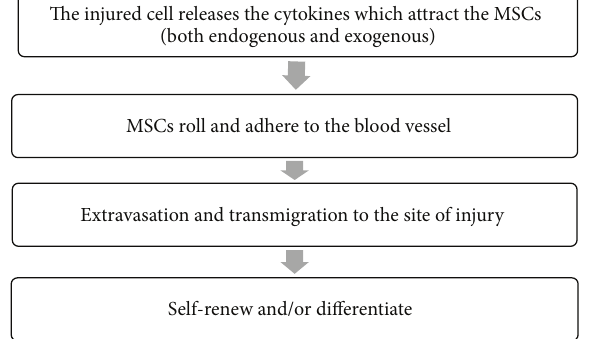
Figure 1: A general scheme is presented to provide an overview on the migration of MSCs to an area of tissue injury. Top row shows the release of cytokines at the region of the tissue to attract the MSCs (rows 2 and 3). Upon reaching the tissue, the MSCs can self-renew and suppress the inflammation or can differentiate to replace the damaged